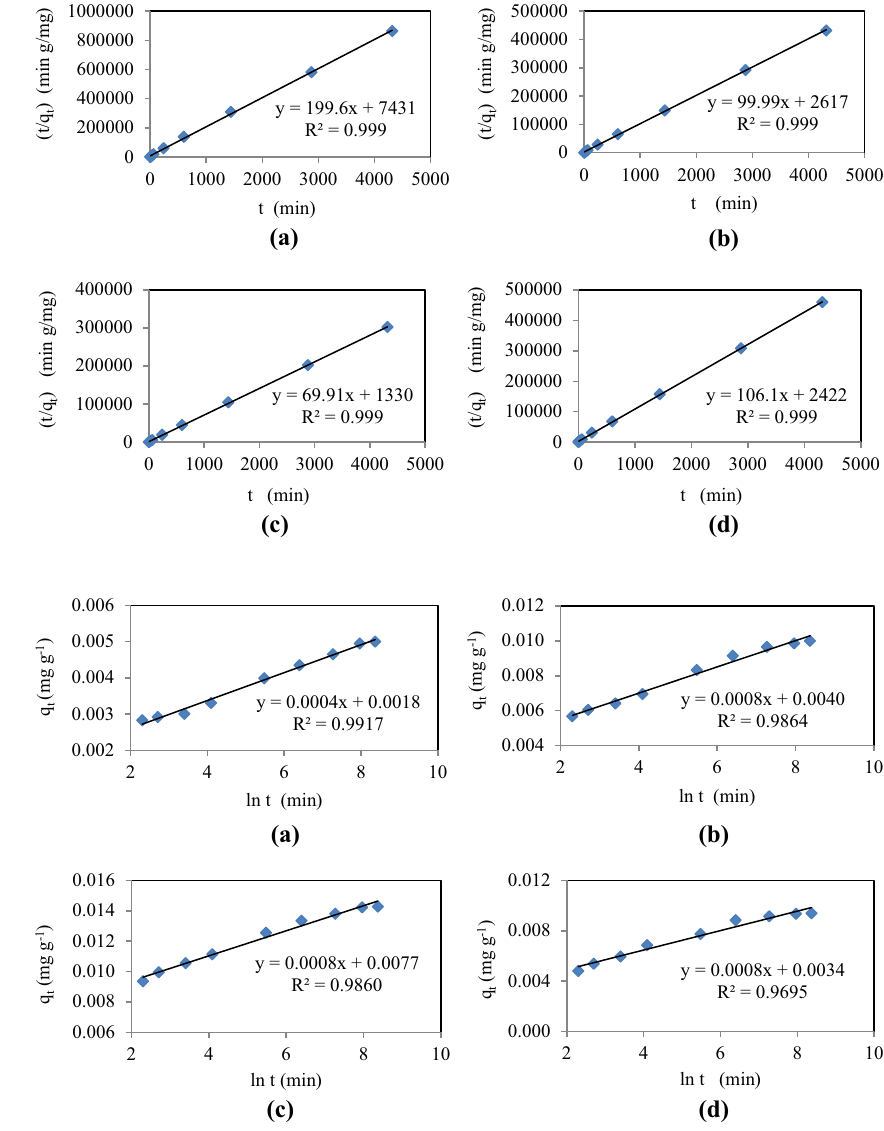
Fig. 10 Elovich Equation Linearization for F −